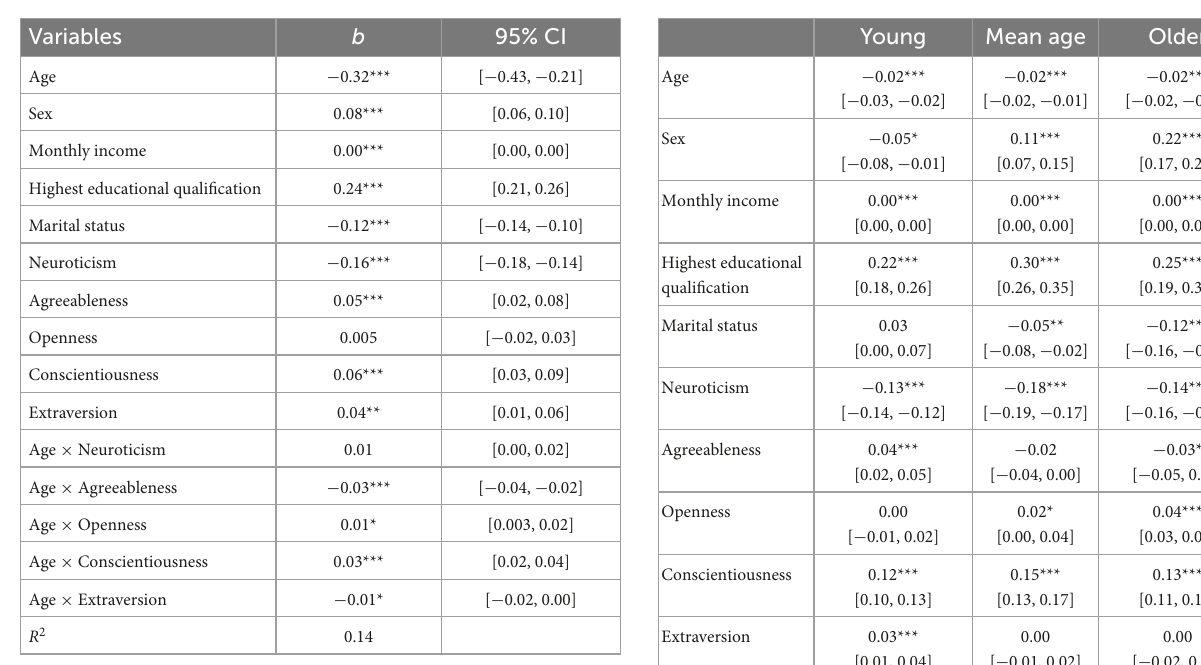
TABLE 5 The regression coefficient ( b ) for demographics, personality traits, and age (categorical) by personality traits interactions with the total explained variances ( R 2 ).